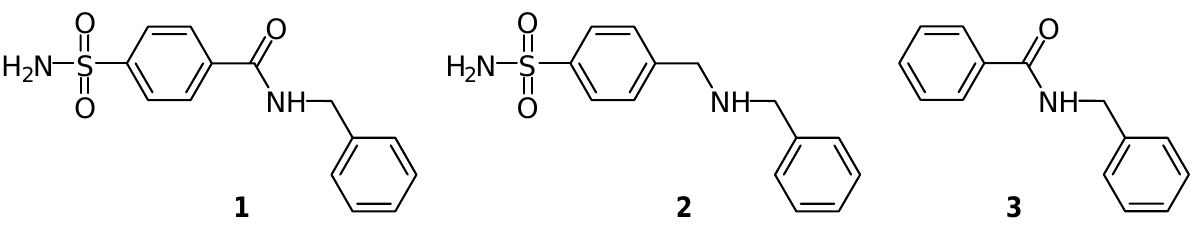
Figure 1. Chemical structure of the template molecule 1 and rebinding analogues 2 and 3